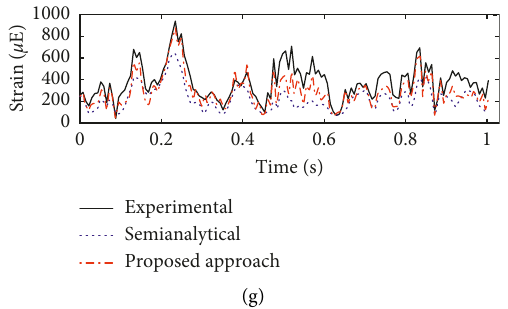
Figure 12: Strain histories at: (a) Point 1; (b) Point 2; (c) Point 3; (d) Point 4; (e) Point 5; (f) Point 6; (g) Point